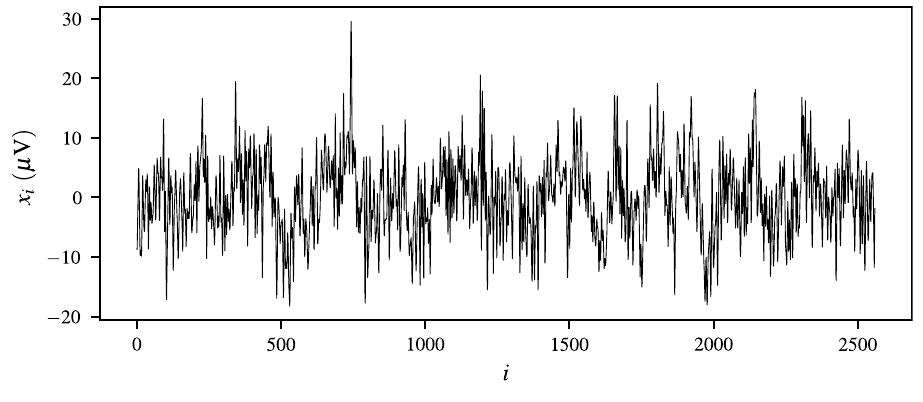
Figure 1. Plot of raw membrane potentials against